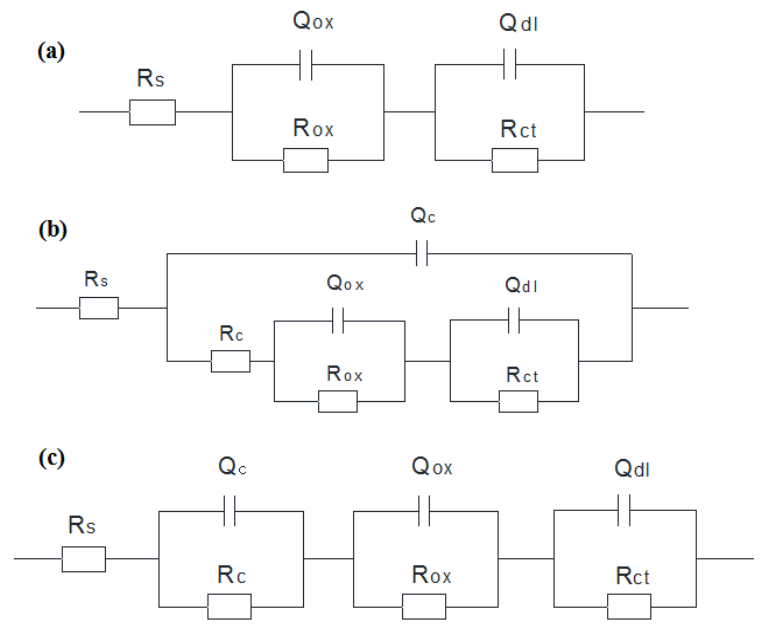
Figure 4. Equivalent electrical circuits (EECs) used for simulating the EIS spectra of 304 SS in seawater after cathodic polarization at different potential. EEC used at the first stage of polarization ( a ), at the second stage with imperfect calcareous deposits ( b ), and at the later stage with complete calcareous deposits ( c ).